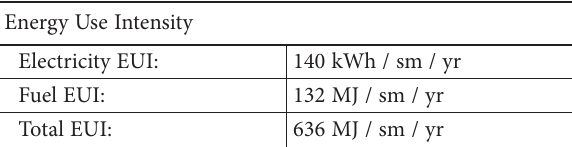
Table 6. Best optimal solution (DD)